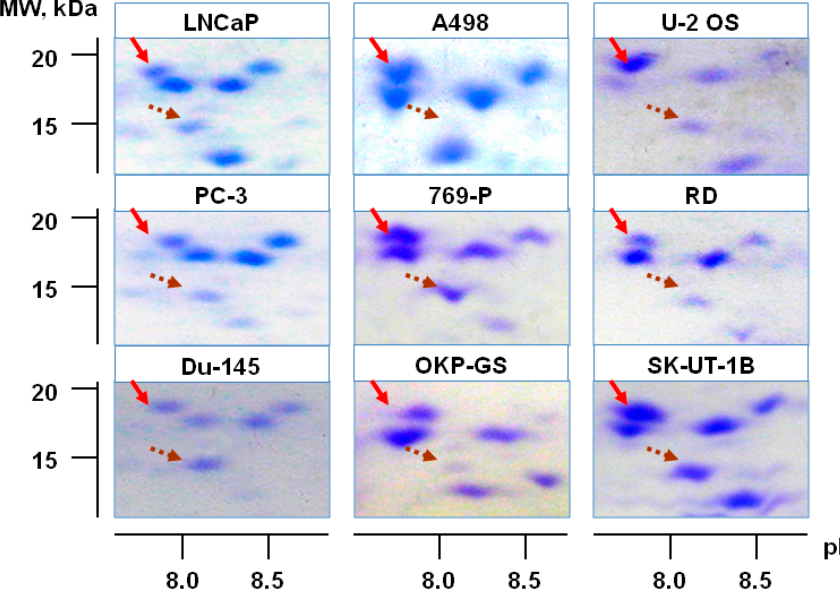
Figure 4. Fragments of two-dimensional electrophoregramms of human malignant cells (HMCs) derived from prostate adenocarcinoma (LNCaP, PC-3, Du-145), renal adenocarcinoma (A498, 769-P, OKP-GS) and sarcoma (U-2 OS—osteosarcoma; RD—rhabdomyosarcoma; SK-UT-1B—leiomyosarcoma) cells lines. The red arrow shows the identified Cfl-1 fraction, and the brown dotted arrow shows the profilin fraction as a reference spot.